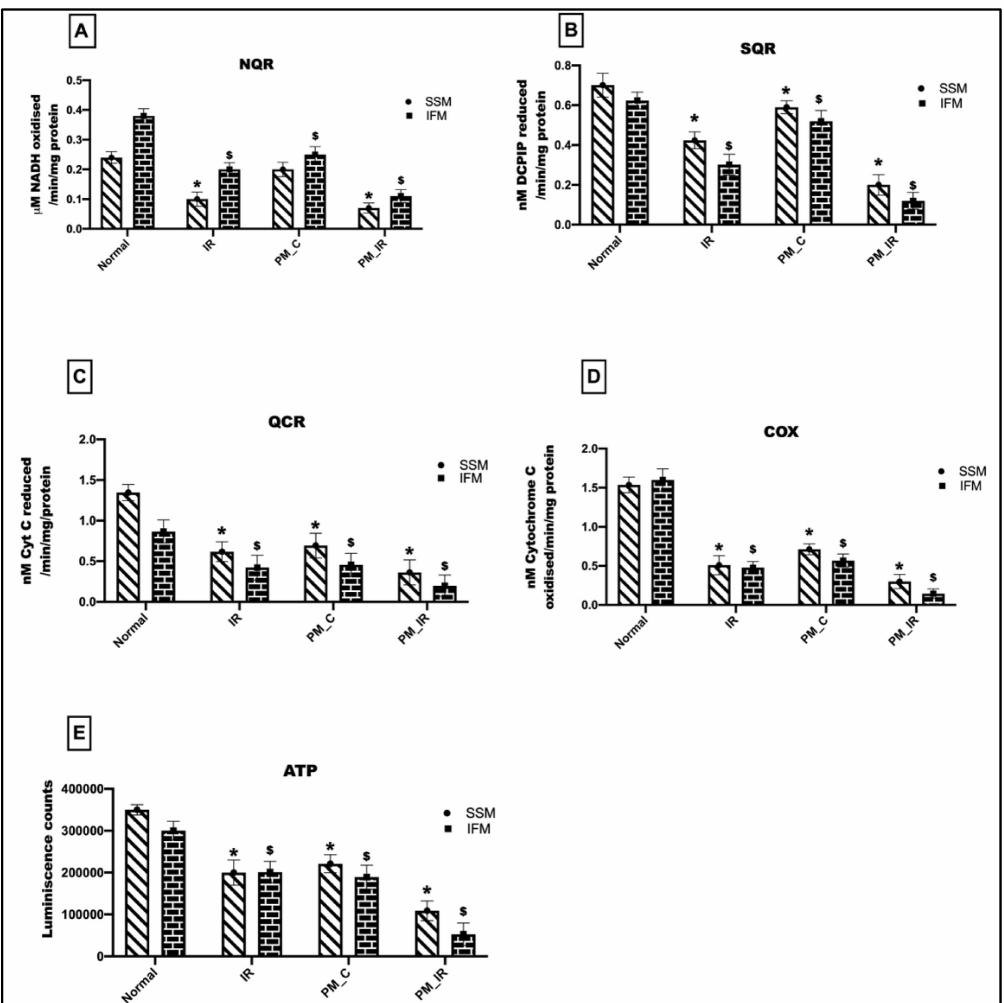
Figure 4. Assessment of mitochondrial ETC complex activities: ( A ) NQR, ( B ) SQR, ( C ) QCR, ( D ) COX, ( E ) ATP assessment. (* p < 0.05 vs. normal of SSM, $ p < 0.05 vs. normal of IFM). Values are mean ± SD. ( n = 6 per group). [Groups: (1) Normal, (2) IR, (3) PM_C, (4)